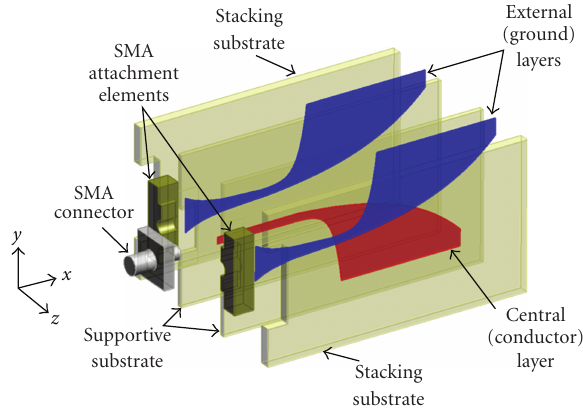
Figure 1: Exploded view of the BAVA antenna.